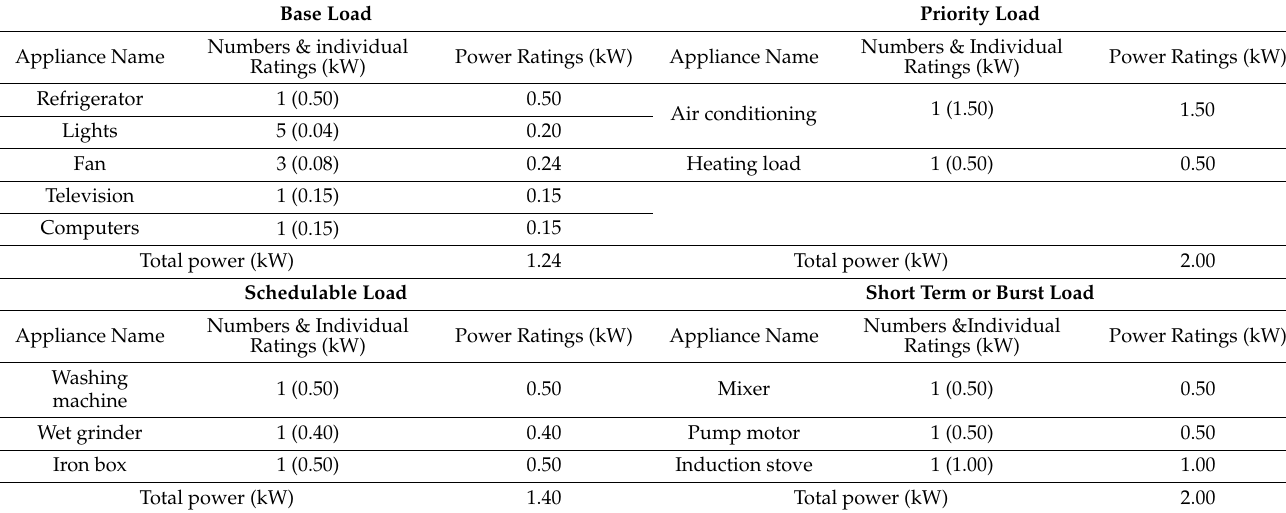
Table 3. Domestic consumer load